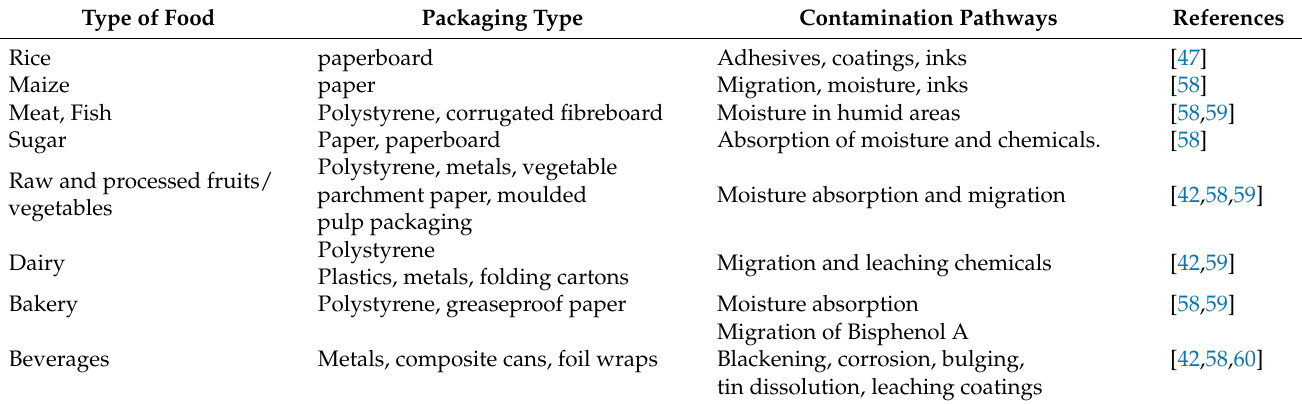
Table 1. Summary of selected food packaging and how contamination is